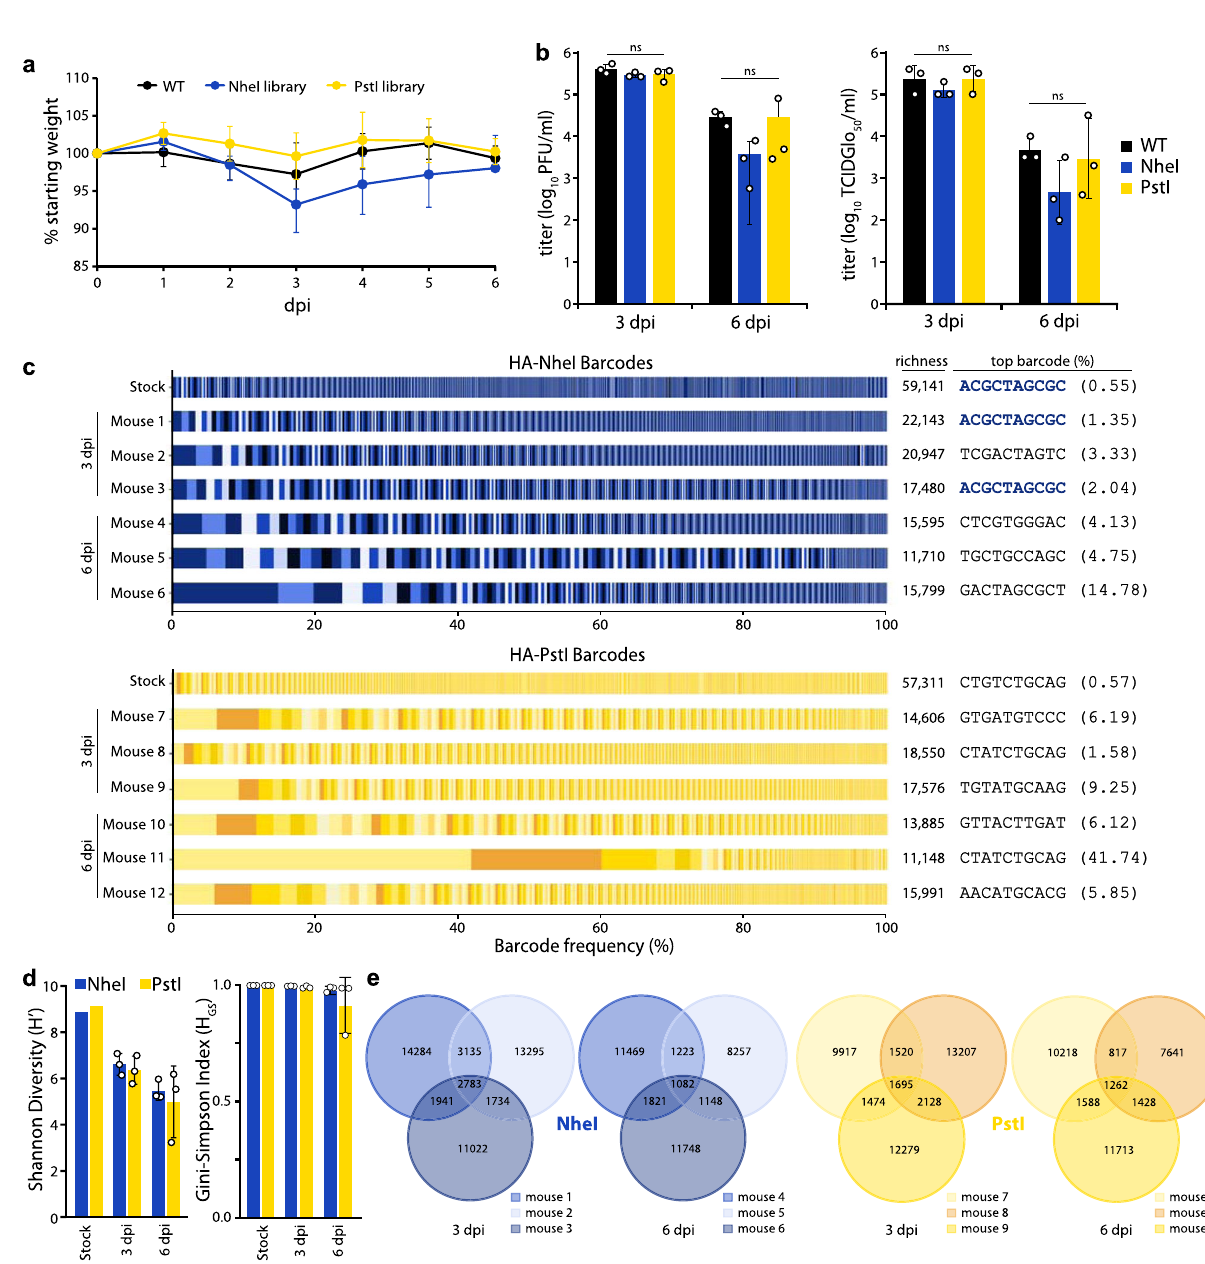
Fig. 4 Replication of diverse virus populations in mice. a Mice were inoculated with 105 TCIDGlo50 of virus-containing barcoded PASTN with either HA- K153E or barcoded variants and body weights were measured daily. Half of the mice were killed at 3 dpi. Data presented as mean ± sd for n = 6 1 – 3 dpi, and n = 3 for 4 – 6 dpi. b Viral titers in mouse lungs harvested at 3 and 6 dpi were determined by plaque assay (left) or TCIDGlo50/mL (right). Data presented as the mean of n = 3 ± sd and analyzed by one-way ANOVA. n.s. = not signi fi cant. c Barcodes in the viral stock and mouse lungs were quanti fi ed and the frequency of clustered HA barcodes as a fraction of total population size is indicated. Each color in a series represents an individual barcode cluster. A total number of unique barcode clusters per sample and the most abundant barcode with its frequency is listed on right. d Shannon ’ s diversity index (left) and Gini – Simpson index (right) for viral populations in the stock and mouse lungs (mean of n = 3 ± sd). e Venn diagrams displaying the number of unique and shared lineages within each mouse for NheI and PstI libraries. Source data are provided as a Source Data fi